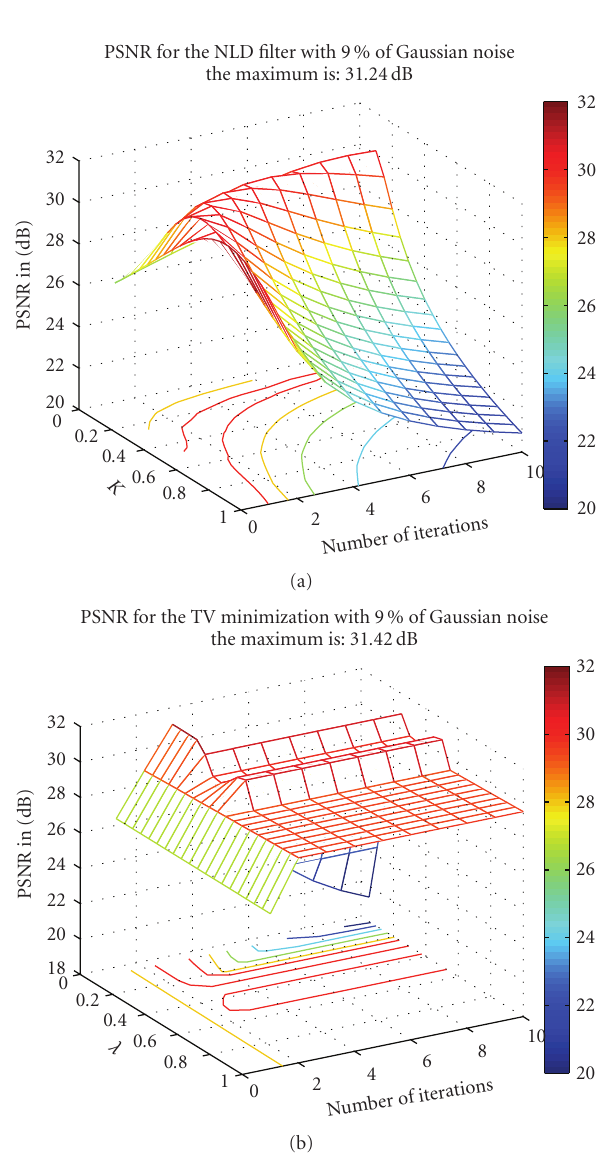
Figure 8: Result for the NLD filter and the TV minimization on phantom images with Gaussian noise at 9%. For the NLD filter, K varied from 0 . 05 to 1 with a step of 0 . 05 and the number of itera- tions varied from 1 to 10. For the TV minimization, λ varied from 0.01 to 1 with a step of 0.01 and the number of iterations varied from 1 to